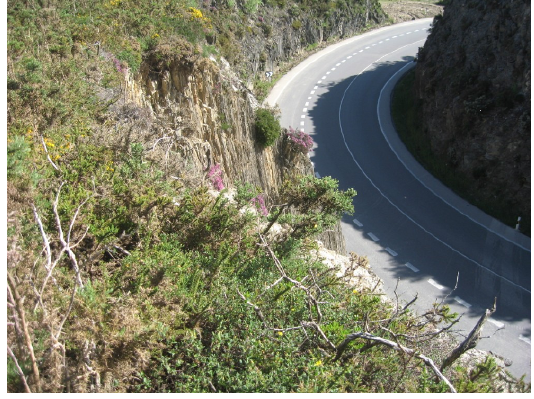
Figure 4: Photo of the studied road